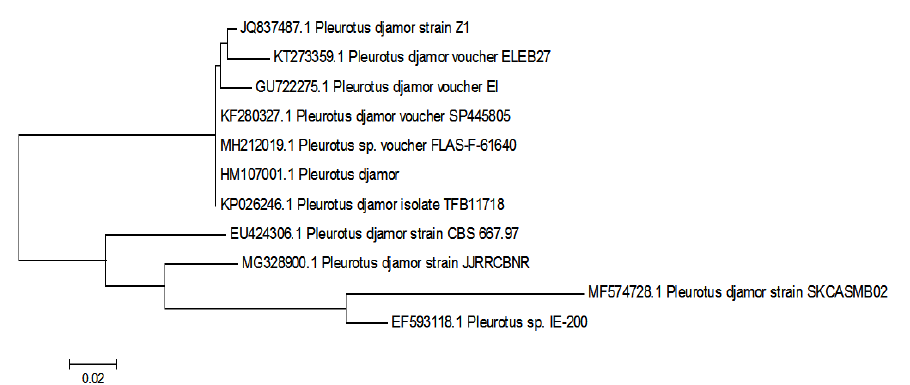
Fig. 4. Phylogenetic tree of P.djamor